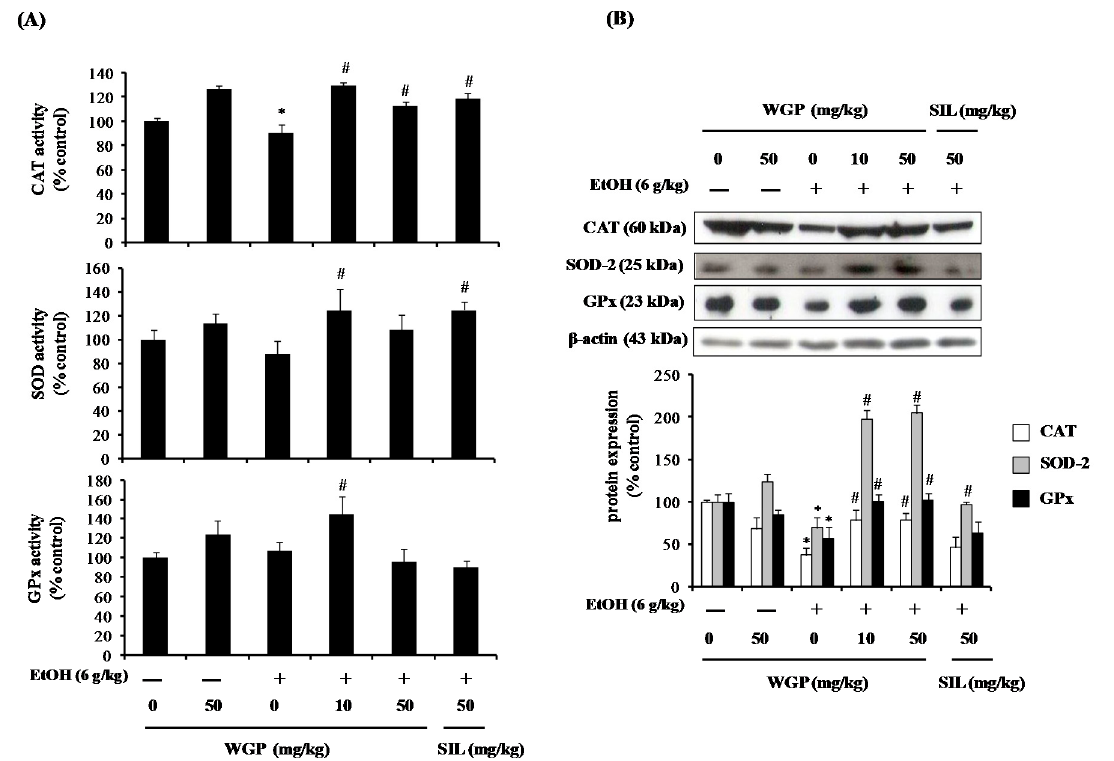
Figure 7. Effect of WGP on the activity and protein level of antioxidant enzymes in ethanol-treated SD-rats. ( A ) Activities of CAT, Mn-SOD, and GPx; and ( B ) protein expression levels of CAT, SOD-2, and GPx. Each value represents the mean ± SD for five rats. * p < 0.05 indicates differences from the unstimulated-control group; # p < 0.05 indicates differences from the ethanol-treated group.